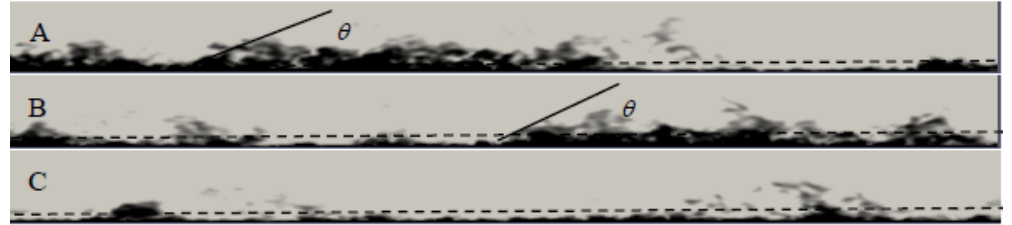
Figure 17. Streamwise velocity fluctuations normalized by the friction velocity in xz plane of case-3. The lines A, B and C in the Figure 16c are shown here.